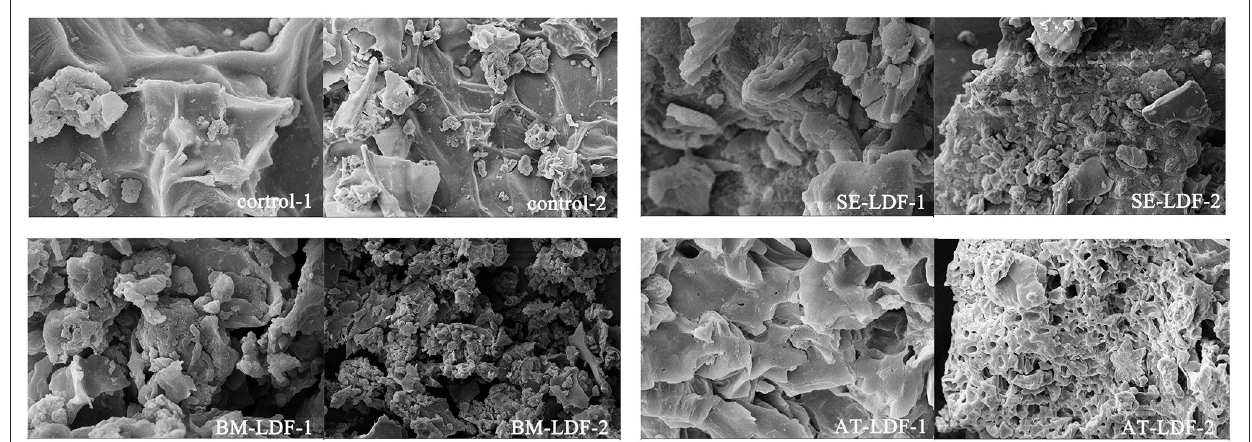
FIGURE1 SEM images of control, SE-LDF, BM-LDF, and AT-LDF. Magnification: 1 (10k × ), 2 (2k × ). Control: lotus leaves dietary fiber. SE-LDF, shear emulsifying modified lotus leaves dietary fiber; BM-LDF, ball milling modified lotus leaves dietary fiber; AT-LDF, autoclave modified lotus leaves dietary fiber.